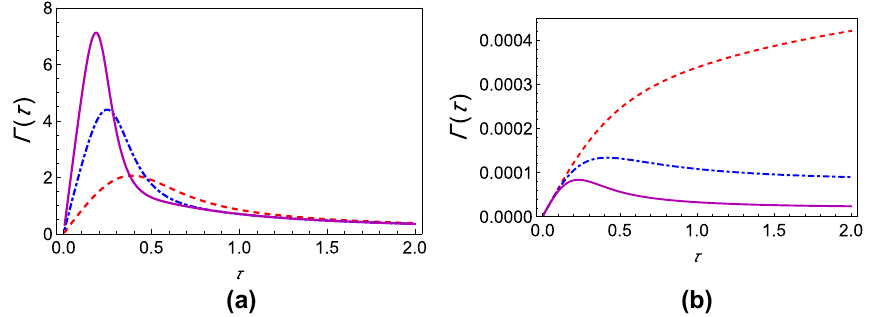
Figure 1. Variation of the effective decay rate with system–environment coupling strength. ( a ) Graph of Ŵ(τ) (at zero temperature) as a function of τ with G G 3 (solid magenta curve). The initial state is cos (θ/ 2 ) = other φ would give the same results here. We have also used a super-Ohmic environment ( s 1 , and (cid:31) 0.05 . ( b ) Graph of Ŵ(τ) (at zero temperature) as a function of τ with G ε = = G 2 (dot-dashed, blue curve), and G = We have used a super-Ohmic environment ( s